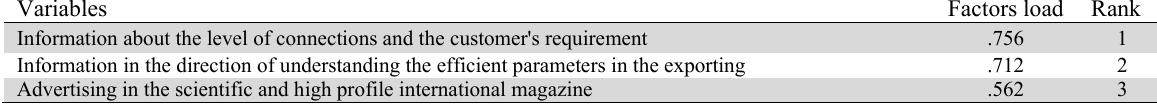
The summary of customer orientation factors influencing on creativity Variables Factors load Information about the level of connections and the customer's requirement .756 Information in the direction of understanding the efficient parameters in the exporting